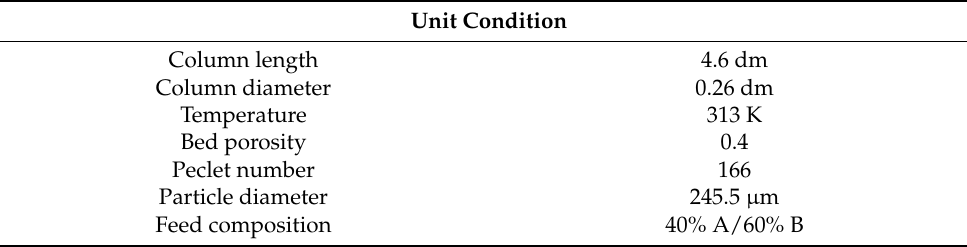
Table 1. Unit conditions for simulations of the TMBR